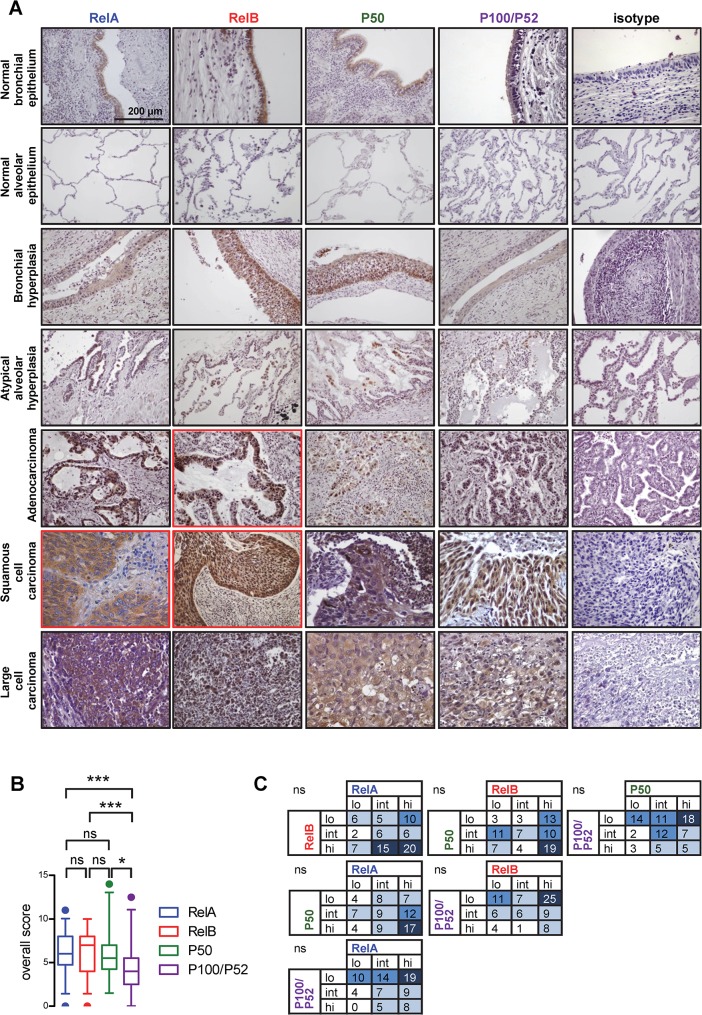
Immunohistochemical detection of NF-κB subunits in NSCLC, juxta-tumoral normal lung structures and preneoplastic lesions.
(A) Representative images. Images in red frames representatively display differential NF-κB subunit expression in tumor and intratumoral stroma areas. (B) Overall scoring of NF-κB subunit expression levels. Data presented as median with boxes indicating interquartile range and whiskers indicating 95% percentiles. ns, * and ***: P > 0.05, P < 0.05, and P < 0.001 for indicated comparisons by Friedman’s test followed by Dunn’s post-tests. (C) Co-expression matrixes of categorical NF-κB subunit expression levels. For this, NF-κB scores from (B) were categorized into low (0–4), intermediate (5–6), and high (7–18). ns: P > 0.05 by χ2 tests followed by Fisher’s exact tests.